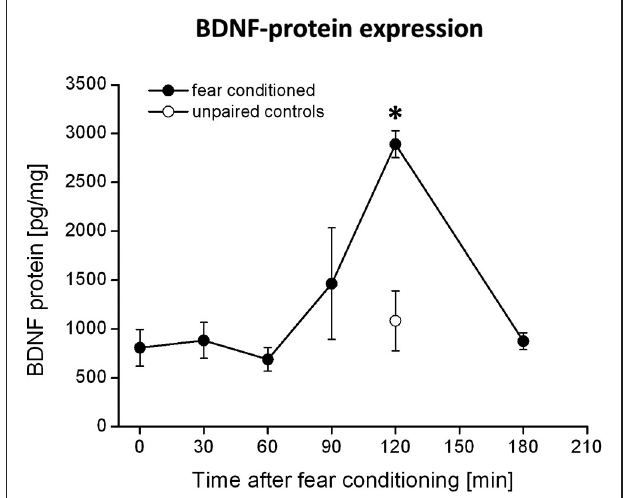
FIGURE 1 | BDNF protein expression in the PRh after fear conditioning training . Animals were fear conditioned, sacrificed at distinct time points after fear conditioning and the amounts of BDNF in the PRh were quantified by ELISA. We observed a strong increase in BDNF protein 120 min after fear conditioning training (solid symbols). This increase was absent in the control group (open symbols) which received the CS and US in an unpaired manner. * Represents a p -value <